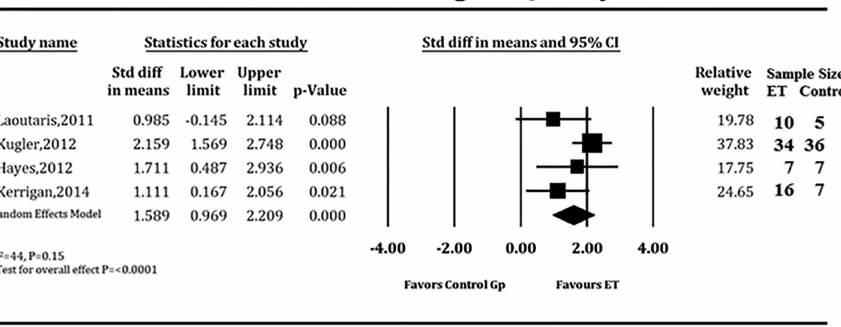
Fig 4. Forest plot depicting effect of supervised exercisetraining on quality of life in LVAD patients. ET = exercise training, Gp = group.